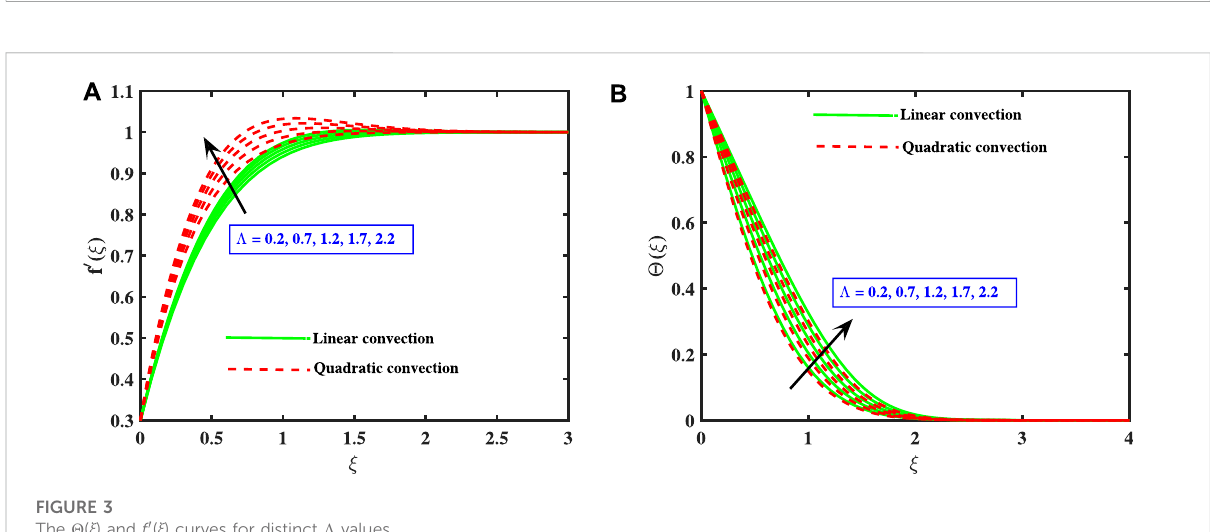
FIGURE 2 The Θ ( ξ ) and f ′ ( ξ ) curves for distinct β values.